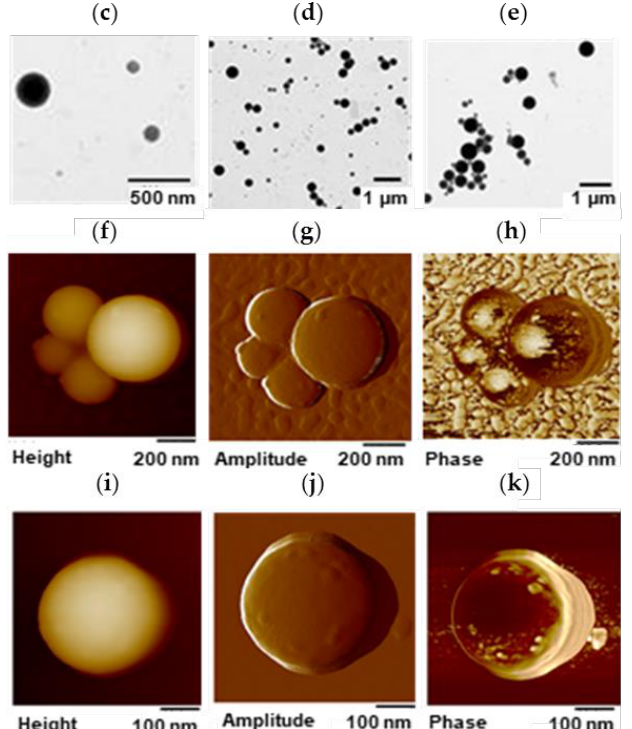
Figure 2. Coating CLPs with β-casein (pH 3.0) evidenced using zeta potential ( a ) and DLC ( b ) measurements as a function of time. TEM images measured from unmodified CLPs ( c ), β-casein coated CLPs ( d ) and β-casein coated CLPs cross-linked with Tgase ( e ). In ( f , g , h ) are shown representative AFM images from enzymatically stabilized CLPs and in ( i , j , k ) are presented the corresponding references.